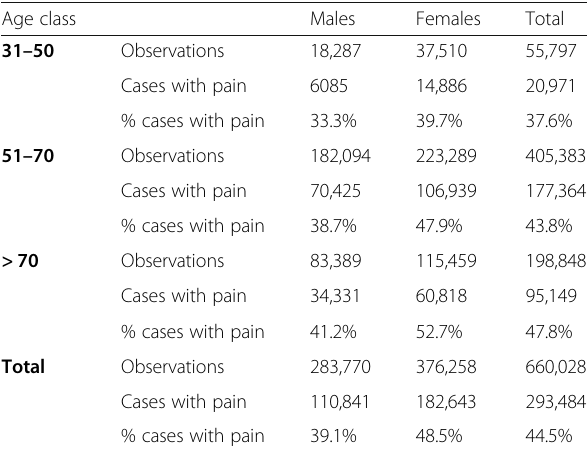
Table 1 Presence of pain in the general population included in ATHLOS harmonized dataset by age